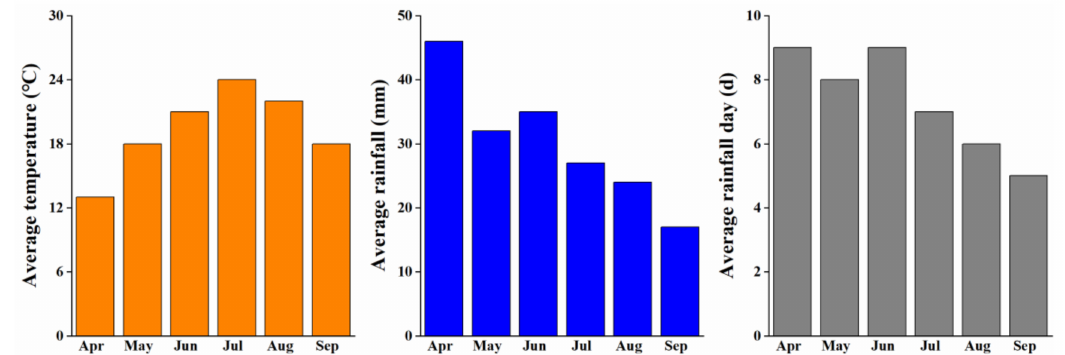
Figure 2. Monthly temperature, precipitation, daily rainfall of Kulusitai watershed.